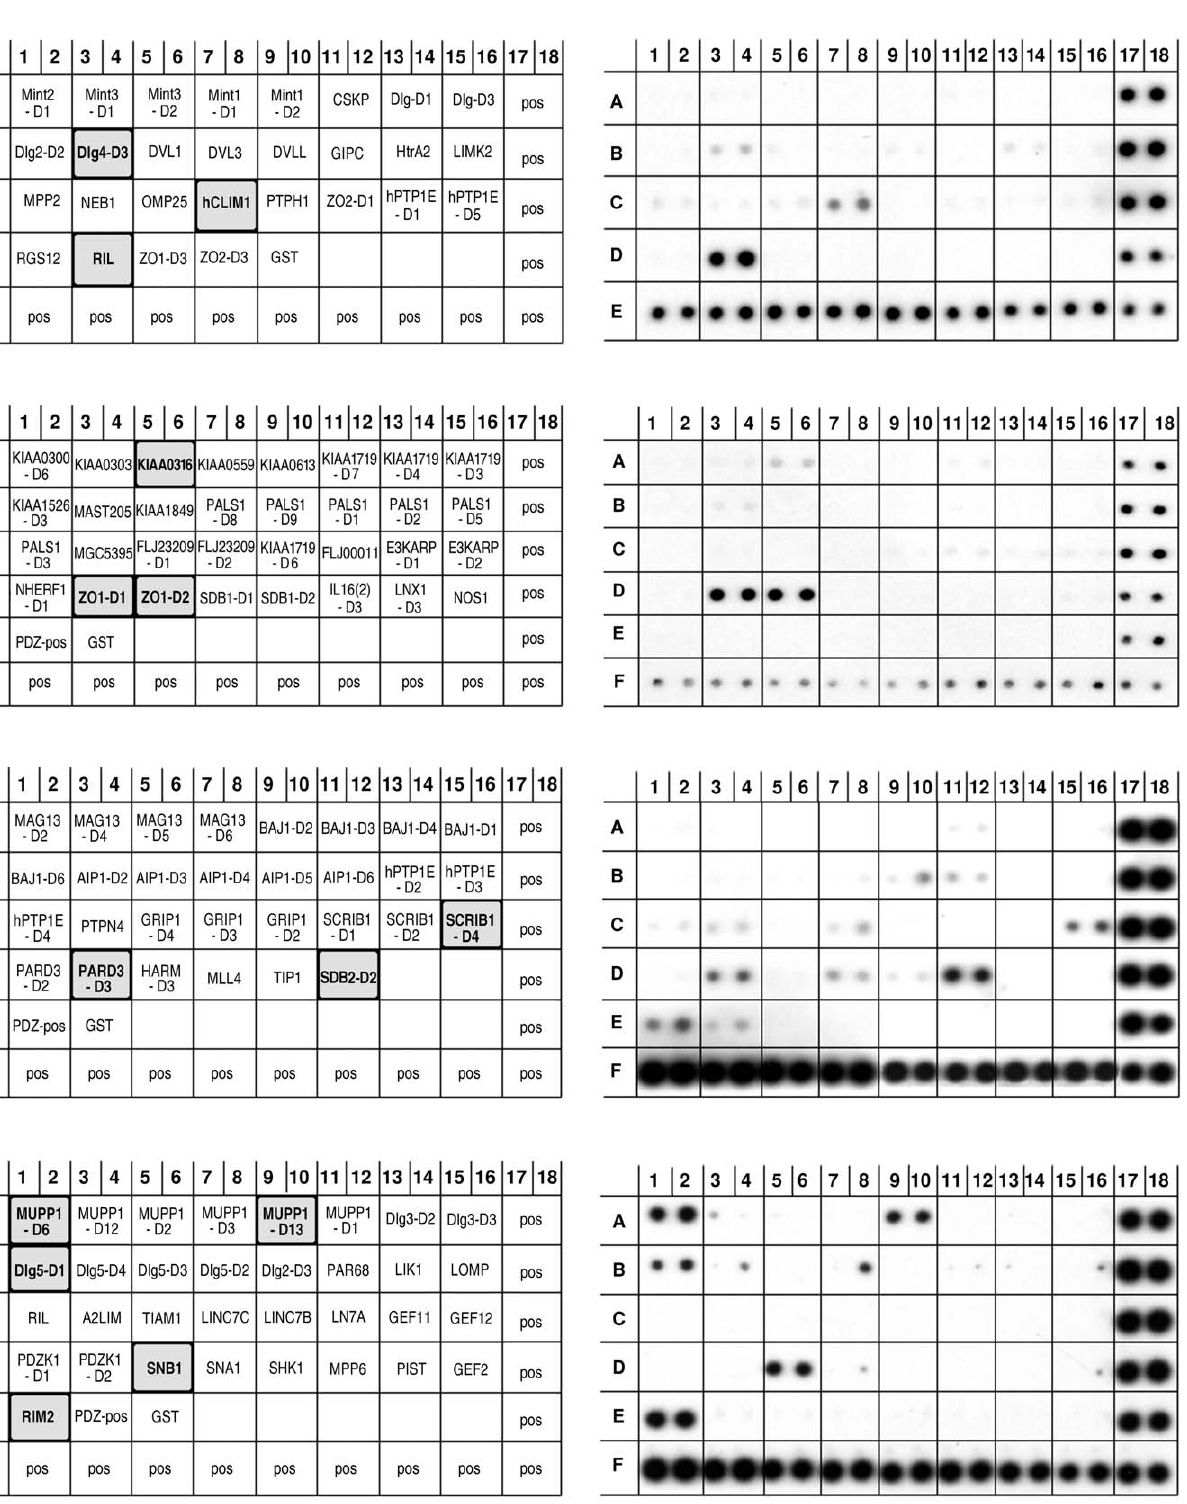
Figure 1. Ankrd2 can bind proteins via their PDZ domain. Panels (A), (B), (C) and (D) show respectively PDZ arrays I, II, III and IV (Panomics/ Affymetrix, USA) probed with His-tagged Ankrd2 (15 m g/ml). On the left are diagrams showing of the positions of the GST-PDZ proteins on the membrane; PDZ proteins that interact with Ankrd2 are highlighted. On the right are the membranes after probing with His-Ankrd2: (A) on PDZ array I a very strong positive signal was detected for the Reversion-induced LIM protein (RIL); weak positive signals for the PDZ and LIM domain protein 1 (hCLIM1) and Discs large homolog 4 (Dlg4). (B) on PDZ array II positive signals were detected for domain 1 and 2 of Zonula occludens (ZO-1 and ZO- 2). (C) on PDZ array III positive signals were detected for syntenin-2 beta, domain 2 (SDB2-D2); for partitioning-defective 3 homolog, domain 3 (PARD- 3) and for Scribble domain 4 (SCRIB1-D4). (D) on PDZ array IV positive signals were detected for domains 6 and 13 of the MUPP1 protein (MPDZ,